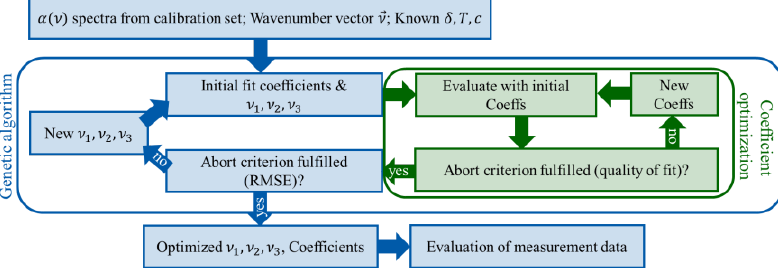
Figure 10. Schematic of the wavenumber optimization procedure. For each wavenumber combination, the coefficient optimization (green box) must be performed within the superordinate wavenumber optimization by means of MATLAB’s genetic algorithm (blue box).